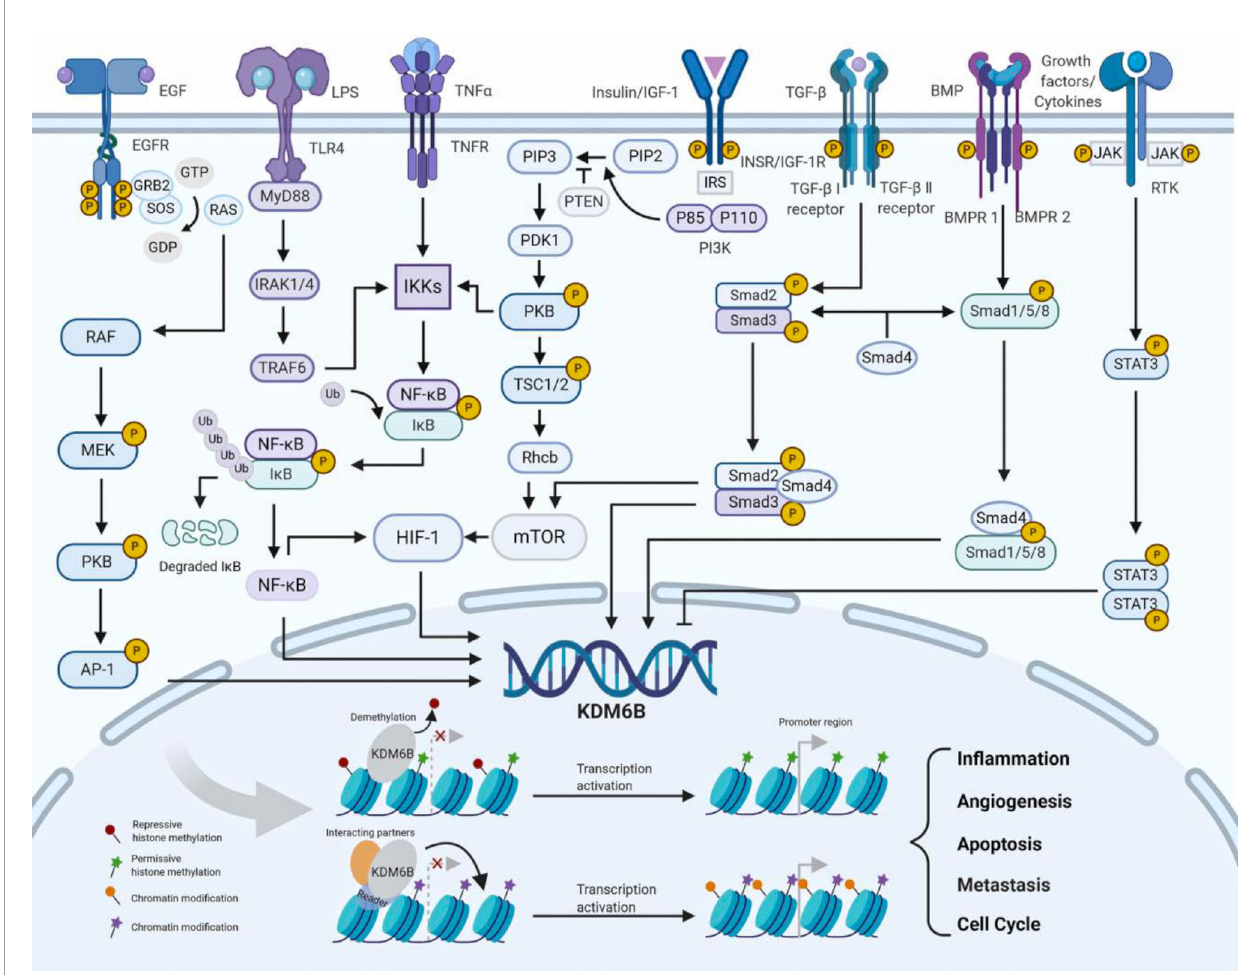
FIGURE 3 | The regulation of KDM6B (Created with BioRender.com).KDM6B isupregulated ordownregulated bygrowth factors, cytokines andcellular stresses via distinctsignaling pathways. KDM6B isrecruited to the chromatin and involved ina widerange of biological processes, such as angiogenesis, metastasis, cell cycle, apoptosisand in fl ammation.AP-1 activator protein 1, BMP bone morphogeneticprotein, BMPR1 bone morphogeneticprotein receptor 1, BMPR2 bone morphogenetic protein receptor 2, EGFepidermal growth factor, EGFR epidermal growth factor receptor, ERKextracellular signal-regulated kinase, GRB2 growth factorreceptor bound protein 2, HIF-1 hypoxia inducible factor-1, IGF-1 insulin-likegrowth factor 1, IGF-1R insulin-likegrowth factor1 receptor,I k B inhibitorof nuclear factor- k B, IKKsinhibitor of nuclear factor- k kinases, INSR insulin receptor, IRAK1/4interleukin-1 receptor-associatedkinase 1/4, IRS insulin receptorsubstrate, JAK Janus kinase, LPS lipopolysaccharide, MEK MAPK/ERK kinase, MAPKmitogen-activated protein kinase, mTOR mammalian target of rapamycin, MyD88 myeloiddifferentiationfactor88, NF- k B nuclear factor- k B,PI3K phosphoinositide 3-kinase, PIP2 phosphatidylinositol- 3,4-bisphosphate, PIP3 phosphatidylinositol-3,4,5-trisphosphate, PDK1 3-phosphoinositide- dependent protein kinase 1, PTEN phosphatase andtensin homolog deleted onchromosome ten,PKB protein kinase B,RTK receptortyrosine kinase, SOS sonof sevenless, STAT3 signal transducer and activatorof transcrip-tion 3 , TGF- b transforming growth factor- b , TLR4 toll-like receptor4, TNF- a tumor necrosis factor- a , TNFR tumor necrosisfactorreceptor,TRAF6 TNFreceptor-associated factor6, TSC1/2 tuberoussclerosis complex